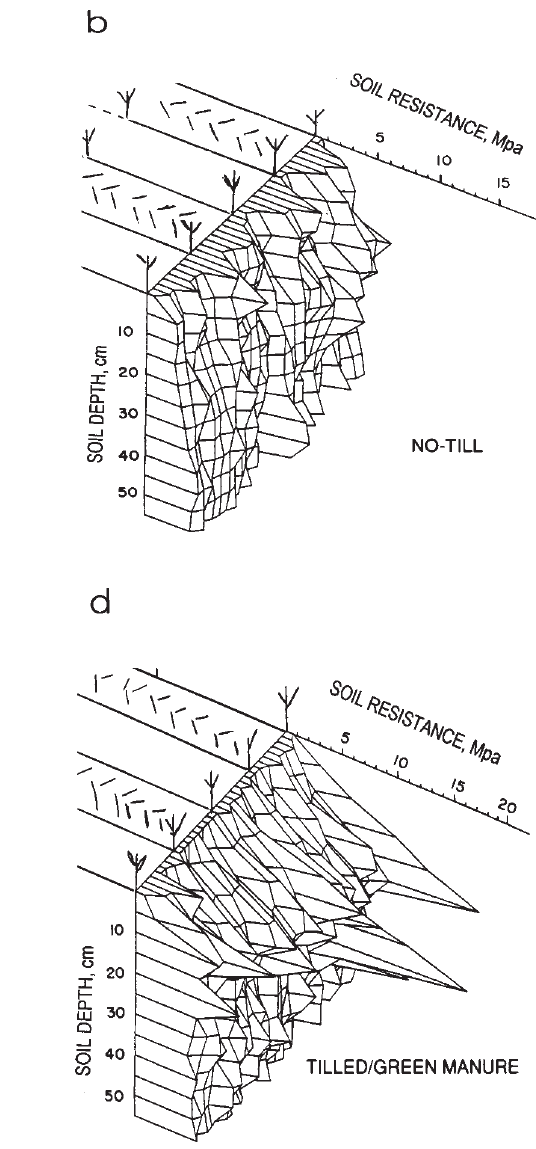
Figure 3. Spatial distribution of 396 measurements of dynamic soil resistance in a vertical section crossing four interrows of the: tilled system (a), no-till system (b), no-till rotation system (c), and tilled/green manure system